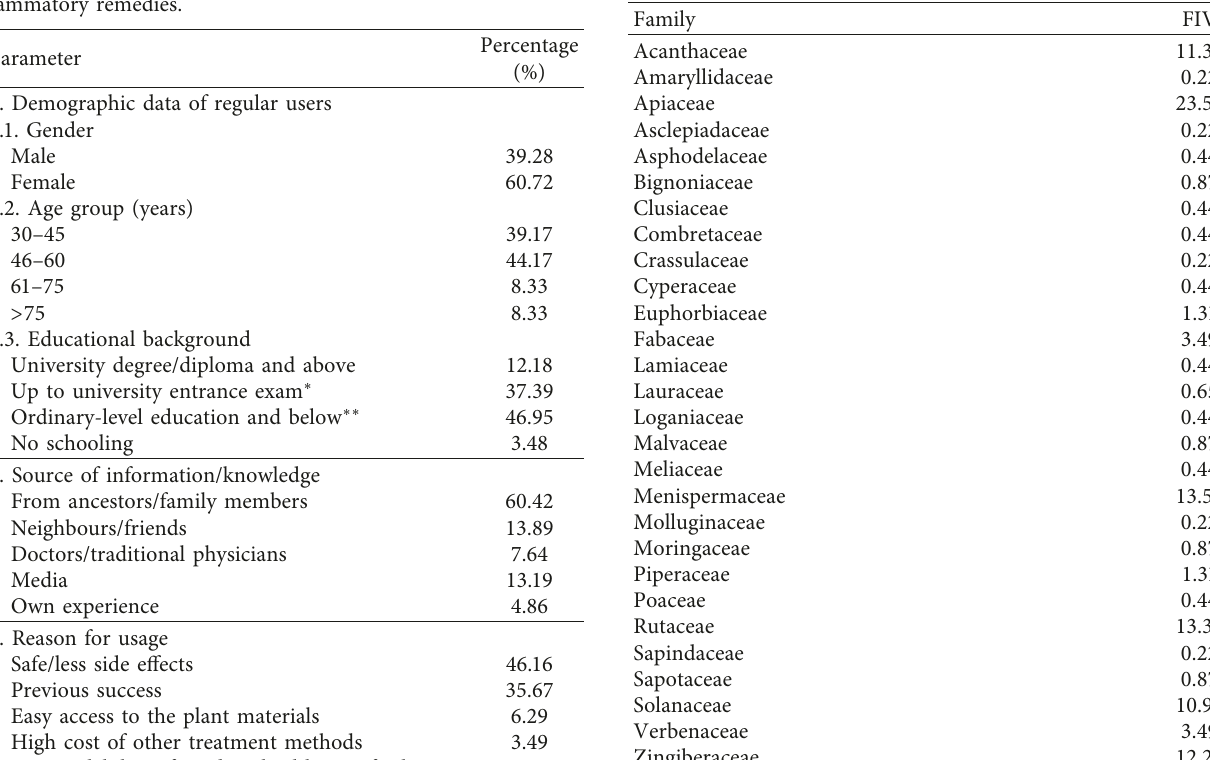
Table 2: Family importance value